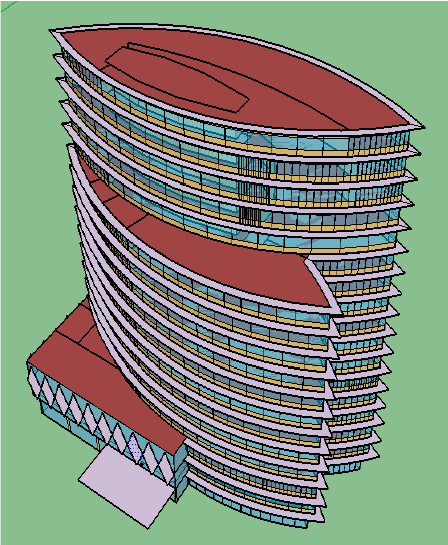
Figure 2. Physical model.